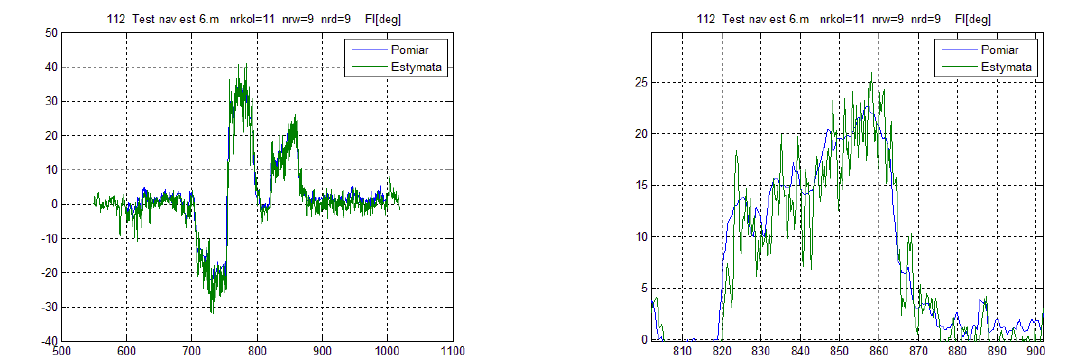
Figure 4. Roll angle [deg] estimation and enlarged fragment on the right – algorithm is described in sub-chapter 2.3